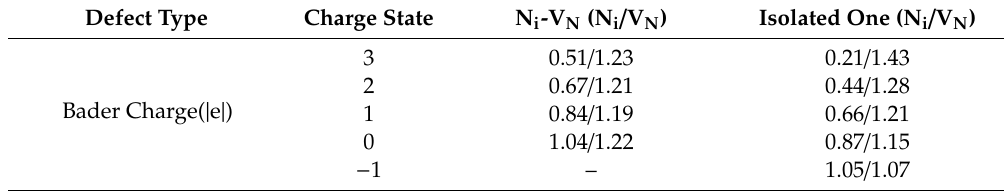
Table 4. Bader charges of N i , V N in the nearest N i -V N and isolated N i , V N